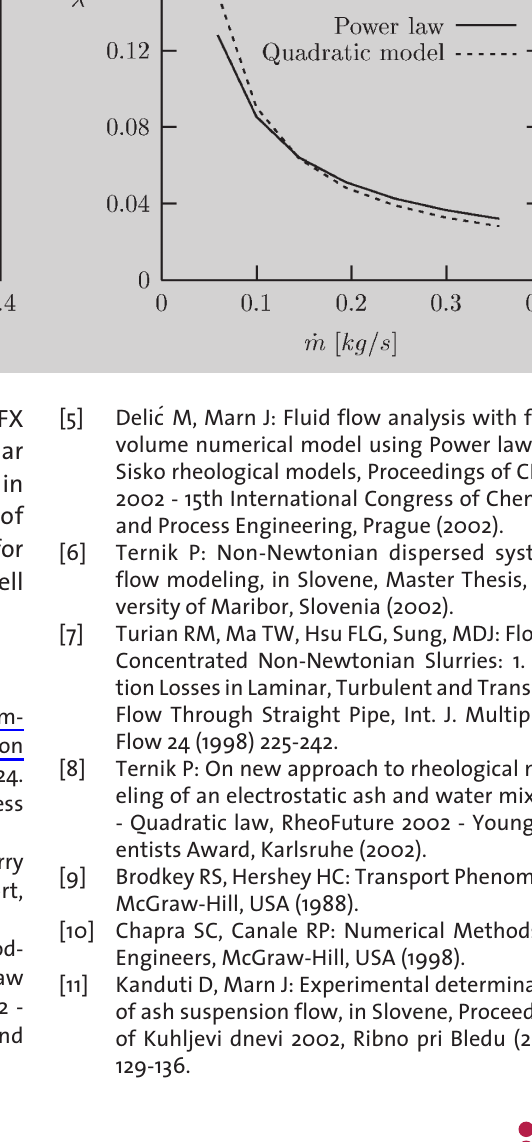
Figure 13: Comparison of results (left: pressure drop, right: major